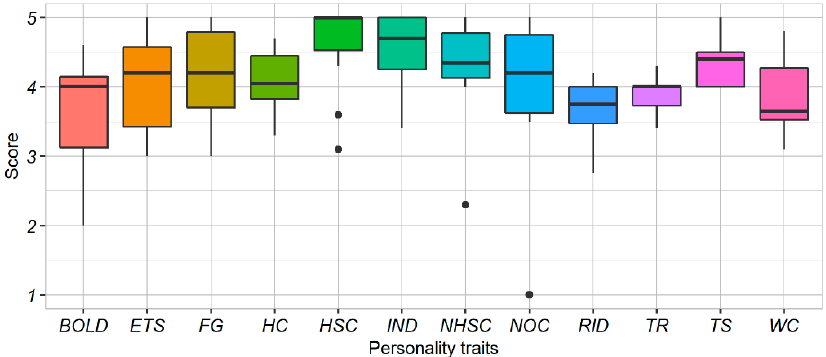
Figure 5. E-BARQ score for each personality trait. The box plots show the median and 25th and 75th percentiles; the whiskers indicate the values within 1.5 times the interquartile range, IQR. The outliers are indicated by the black circles.